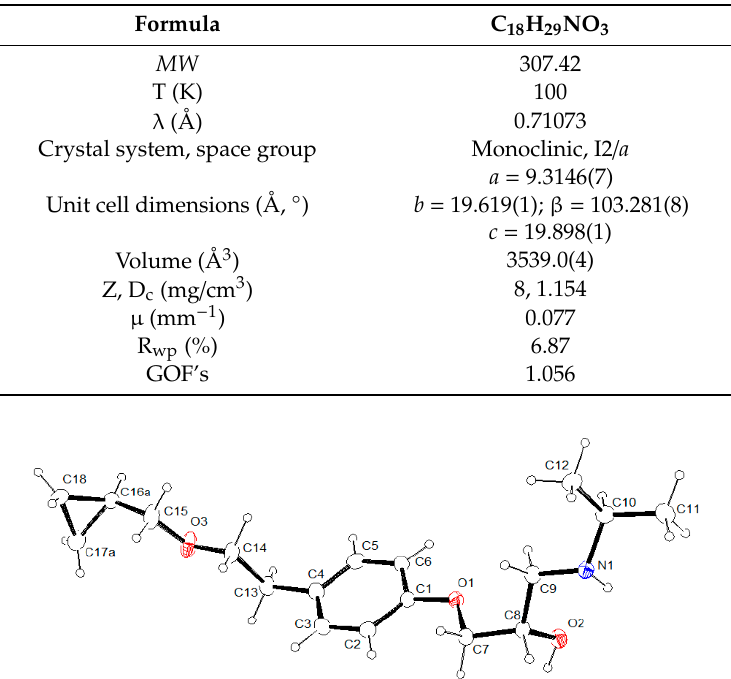
Table 1. Crystallographic data and refinement parameters for BE_IV .